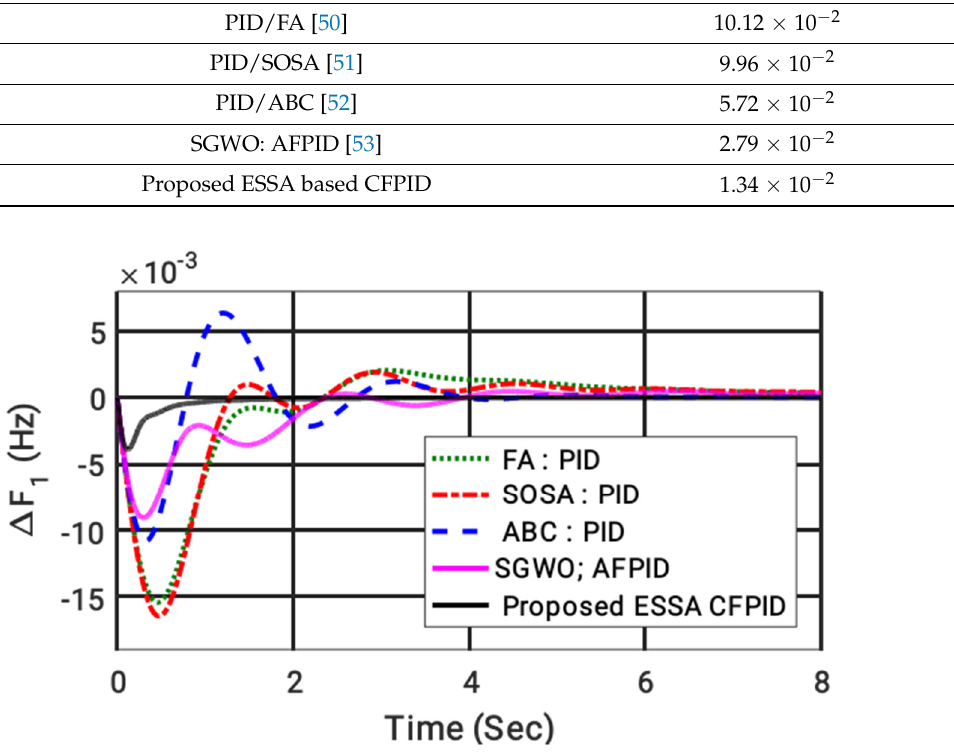
Figure 7. Frequency deviation of first area for 2nd test